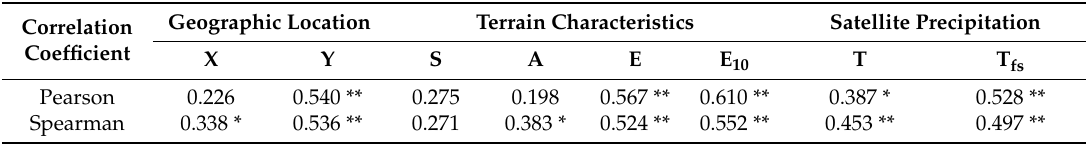
Table 1. Correlation coefficient between the precipitation of 41 stations and each auxiliary variable.